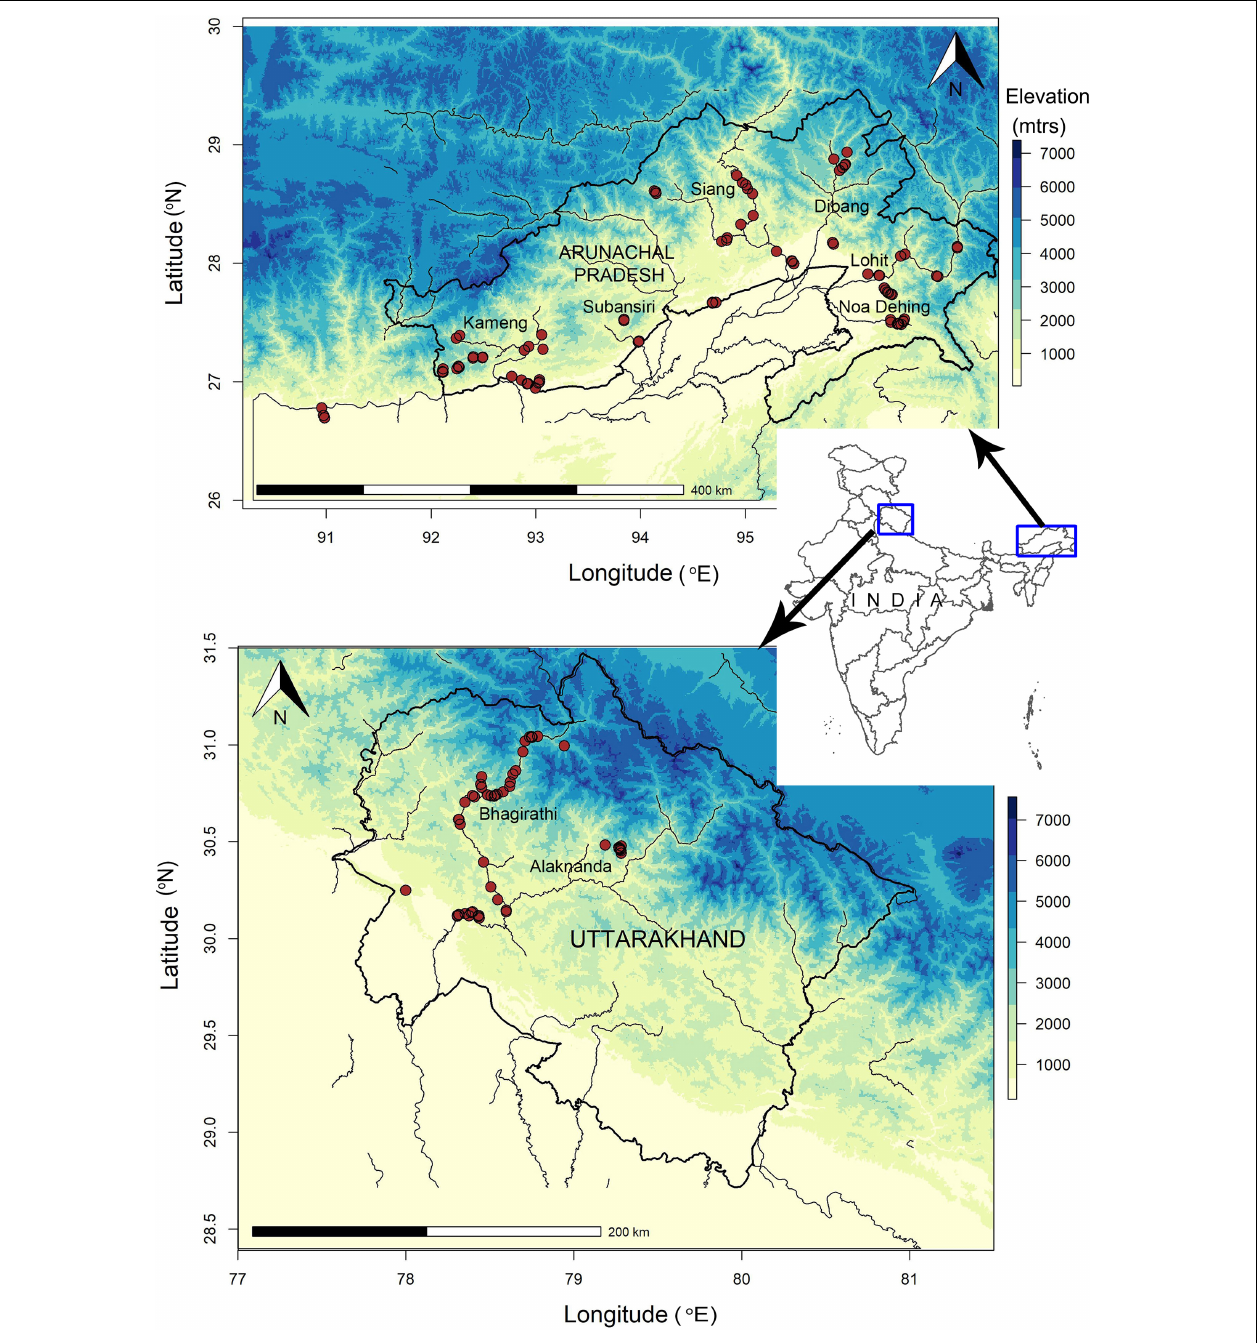
FIGURE 1 | Map showing the study area in the Indian Himalaya. Blue rectangles show the location of political states in the east and west where fieldwork was conducted and circles in red show locations of river stretches sampled. Eighty-one river reaches were sampled in the E Himalaya (Arunachal Pradesh) and 53 in the W Himalaya (Uttarakhand).